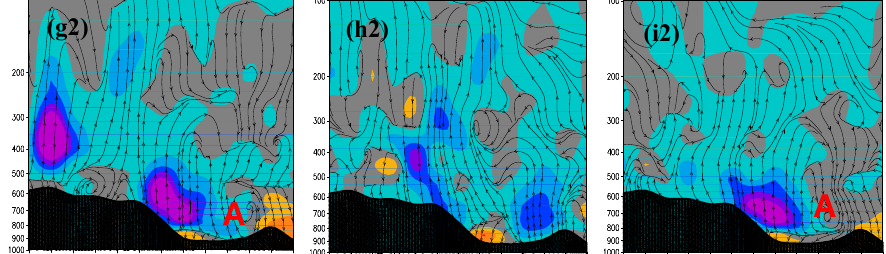
Figure 6. Cross section of vertical circulation along 105° E ( a1 – i1 ) and 32°N ( a2 – i2 ), in which the shaded area is the vertical velocity (Pa/s), the stream line is the synthetic circulation of both horizontal wind (m/s) and vertical velocity ( − 10 − 2 Pa/s). A: anticyclonic vertical circulation; C: cyclonic vertical circulation. ( a1 , a2 ) 1200 UTC 7 July; ( b1 , b2 ) 1800 UTC 7 July; ( c1 , c2 ) 0000 UTC 8; ( d1 , d2 ) 1200 UTC 8 July; ( e1 , e2 ) 1800 UTC 8 July; ( f1 , f2 ) 0000 UTC 9 July; ( g1 , g2 ) 1800 UTC 9 July; ( h1 , h2 ) 0600 UTC 10 July; ( i1 , i2 ) 0000 UTC 11 July. Black areas: terrain.